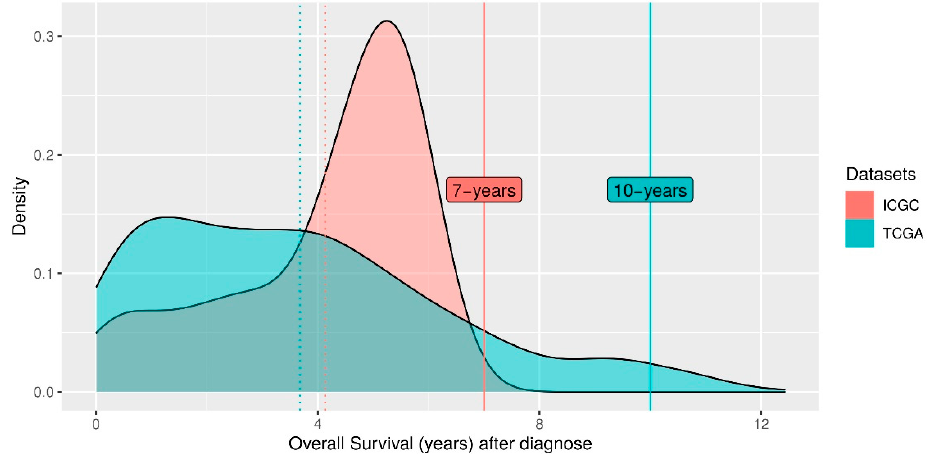
Figure A6. Density plot of the distribution of overall patient survival in TCGA-KIRC and ICGC- RECA. The dotted line indicates the mean of distributions, and the solid lines indicate the time prediction used for internal and external validations. We restrict the 10-year prediction for TCGA- KIRC to exclude outliers in the long tail of the density plot of the patient’s overall survival. For the ICGC-RECA dataset, we decided to maintain a 7-year prediction in order to include all samples, and limit the time prediction to the range of distribution of this dataset for external validation.